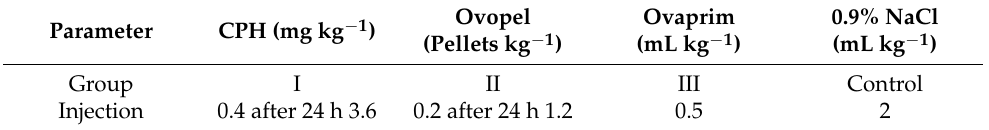
Ovopel Ovaprim 0.9% NaCl (Pellets kg − 1 ) (mL kg − 1 ) (mL kg − 1 )